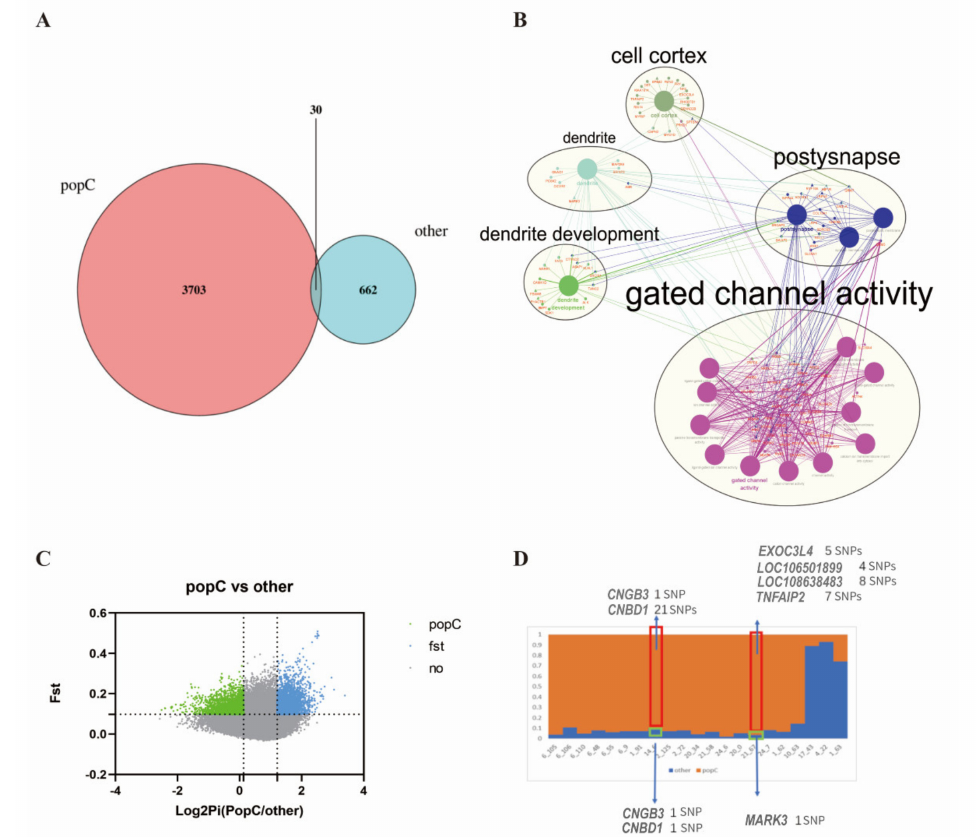
Figure 4. Population − specific SNP annotation and selective signals in Hainan Black goats. ( A ) Venn diagram of the population − specific SNPs in the popC group (Hainan Black goat) and the other group. ( B ) Functional enrichment analysis of 417 genes annotated by the population − specific SNPs. The bigger dot in the circle represents the function cluster, and the smaller dot and triangle in the circle represent genes in popC and other group, respectively. ( C ) Selective clearance analysis between the popC group (Hainan Black goat) and the other group ( θπ ratio: top 1%, Fst: top 1%). ( D ) Proportion of selected regions in the number of population − specific SNPs. Orange represents popC, and blue represents the other group. The abscissa represents the selected regions, chromosome regions with the sliding windows of 1